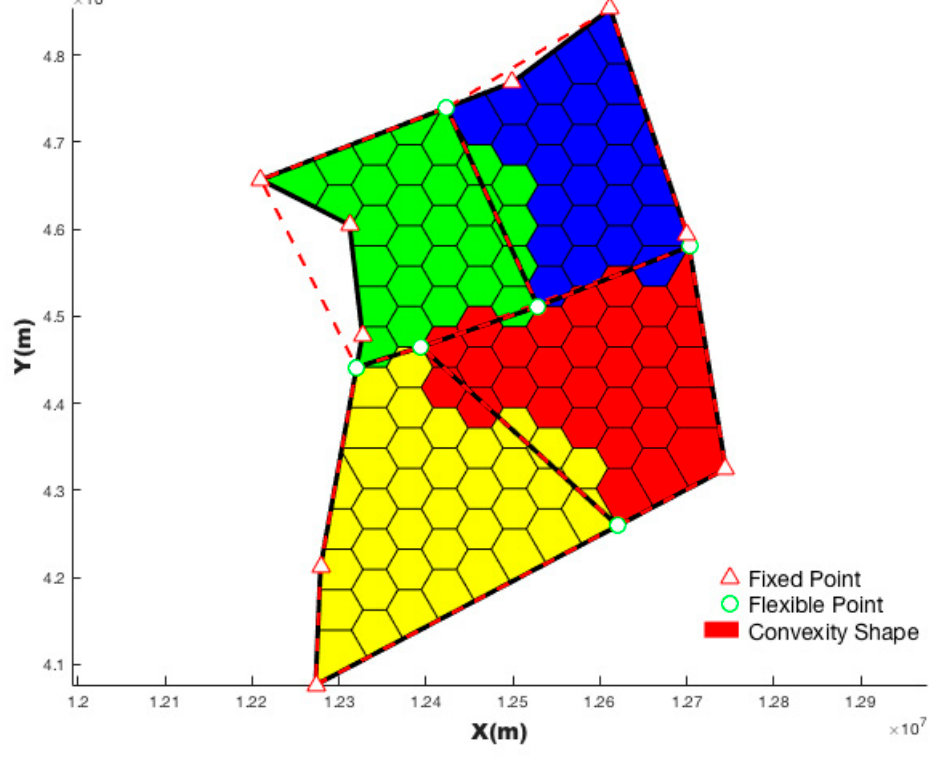
Figure 8. Flexible and fixed vertices.